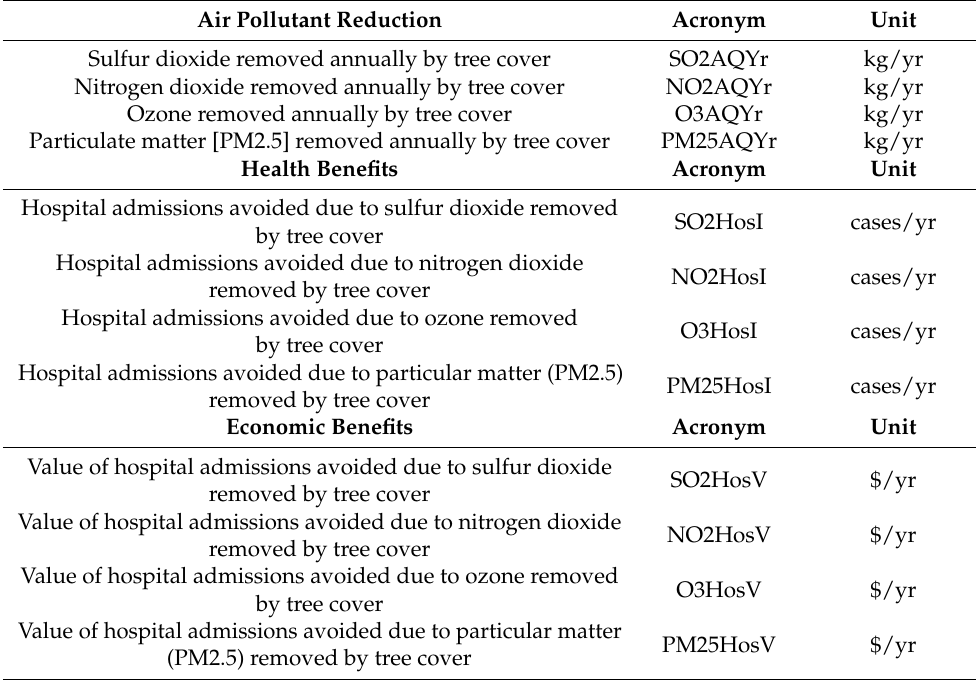
Table 1. Air pollutant reduction, health benefit and economic benefit